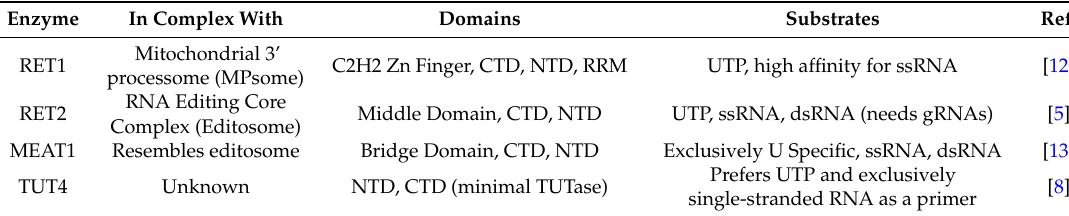
Table 1. Properties of the four TUTase enzymes in this